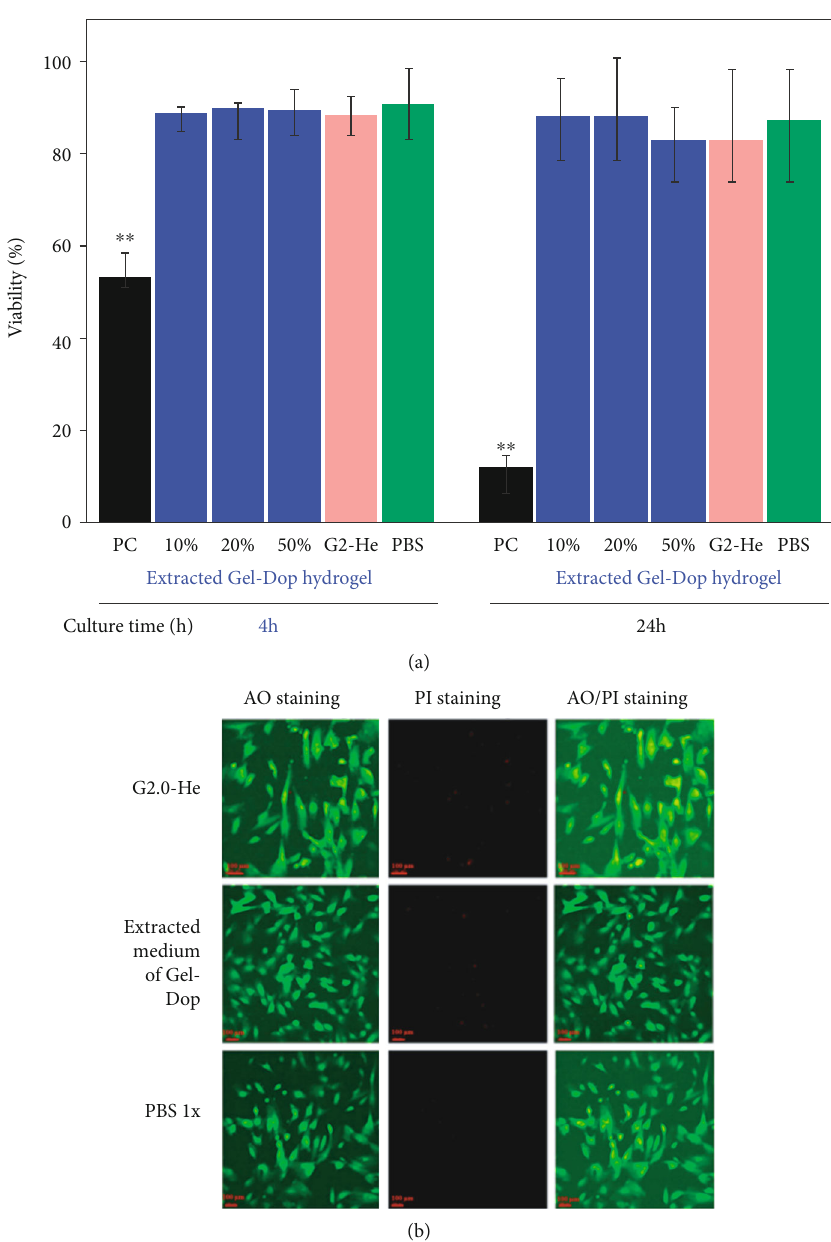
Figure 7: Cytotoxicity evaluation of instituting or forming Gel-Dop hydrogels through G2.0-He under H the cell culture in DMEM) of human fi broblast cells incubated with various concentrations of Gel-Dop hydrogel extract, G2.0-He, positive control (doxorubicin 0.1mM), and PBS 1x using prepared samples for 4h and 24 h. (b) Fluorescence image of human fi broblast cells cultured with G2.0-He, 50% extracted medium of Gel-Dop, and PBS 1x for 24 h. Data are presented as mean ± SEM of three independent replicated results. ∗∗ p < 0 : 01